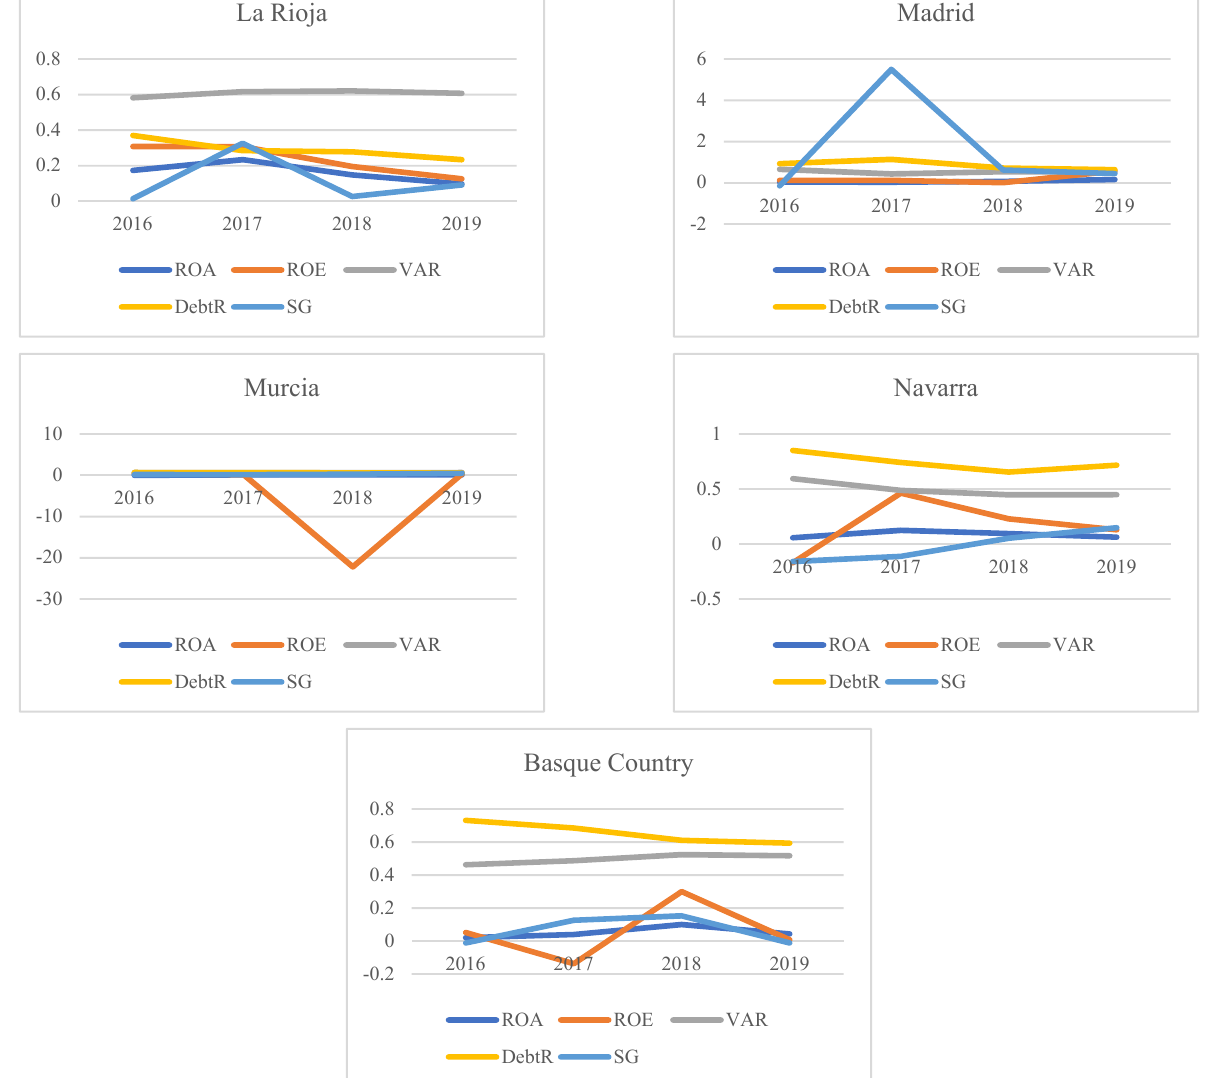
Figure 2. Evolution of financial and economic performance by Spanish NUTs II regions, 2016–2019. ROA: return on assets; ROE: return on equity; VAR: value-added ratio; DebtR: debt ratio; SG: sales growth.